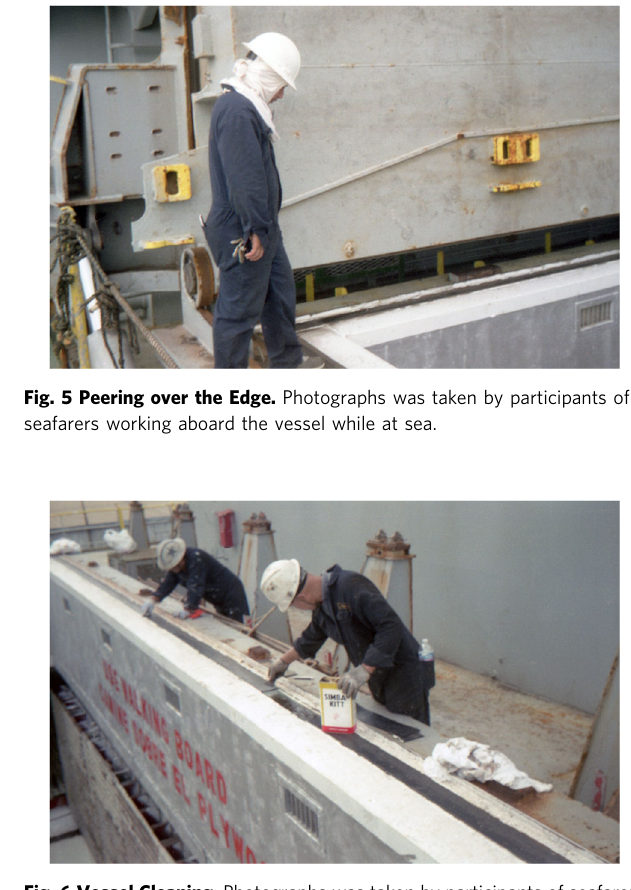
Fig. 6 Vessel Cleaning. Photographs was taken by participants of seafarers working aboard the vessel while at